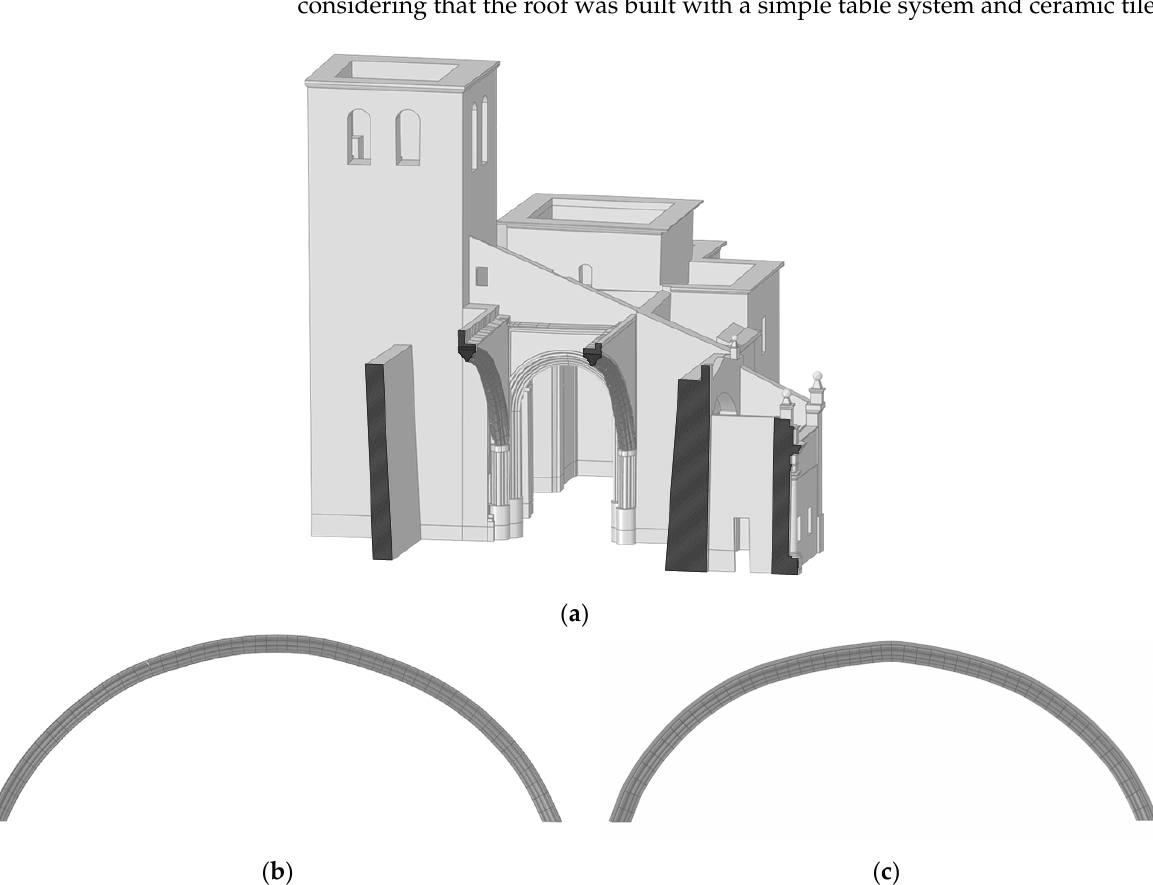
Figure 8. Results obtained during the modelling of the vertical walls and segmental arches: ( a ) vertical walls of the naves; ( b ) the south and ( c ) north segmental arches. It is possible to observe the ability to capture the real geometry of these constructive elements, showing inclinations and non-perfect shapes (in the case of the segmental arches).